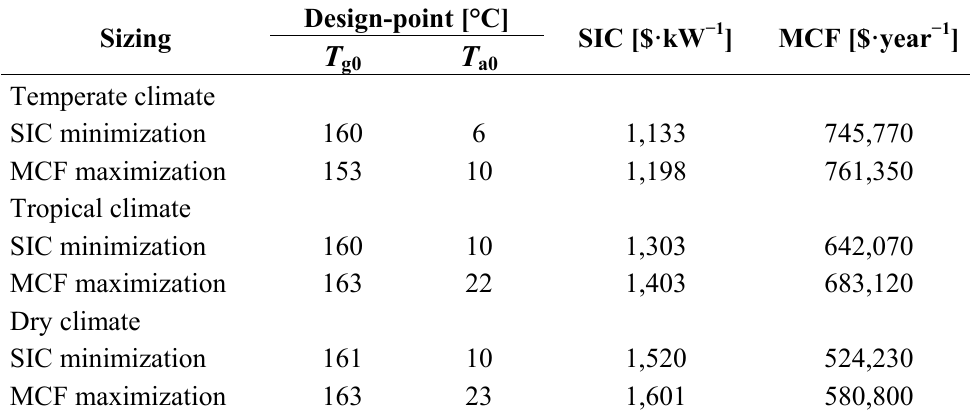
Table 5. SIC and MCF for each optimal design-point and climate type.